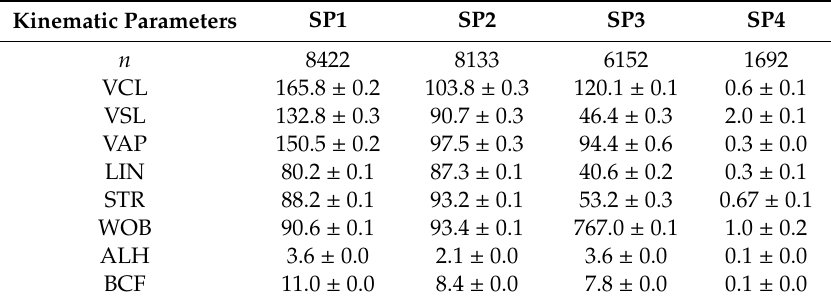
Table 2. Kinematic parameters (mean ± SEM) of each motile sperm population.